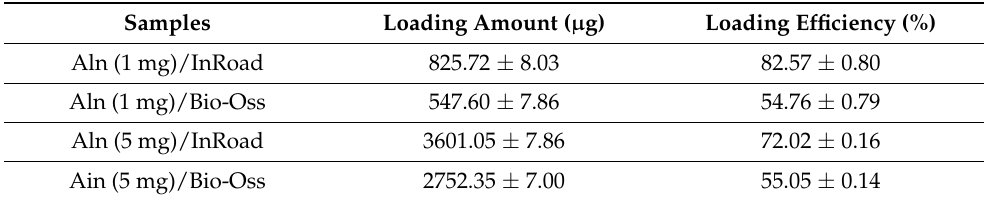
Table 1. Alendronate loading amount and efficiency in both InRoad and Bio-Oss in 1 mg and 5 mg concentration.